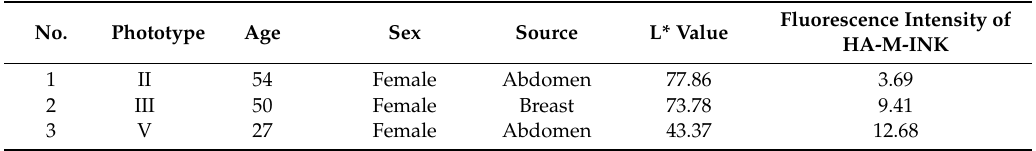
Table 1. Base characteristics of skin samples, their skin surface L* values, and fluorescence intensity of